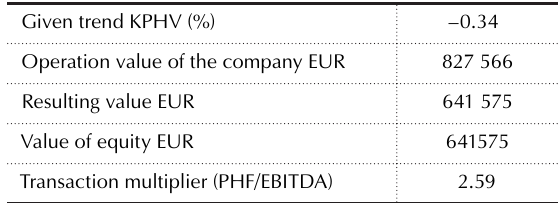
Table 2. Value of the company – model of